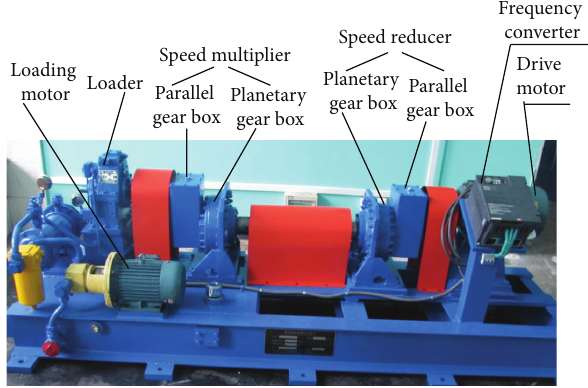
Figure 7: The test bench of the planetary gear system.